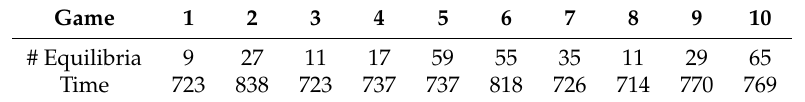
Table legend: Game—Tested 10 games; # Equilibria—The number of equilibrium strategies found for each game; Time—Time in seconds spent on each game.